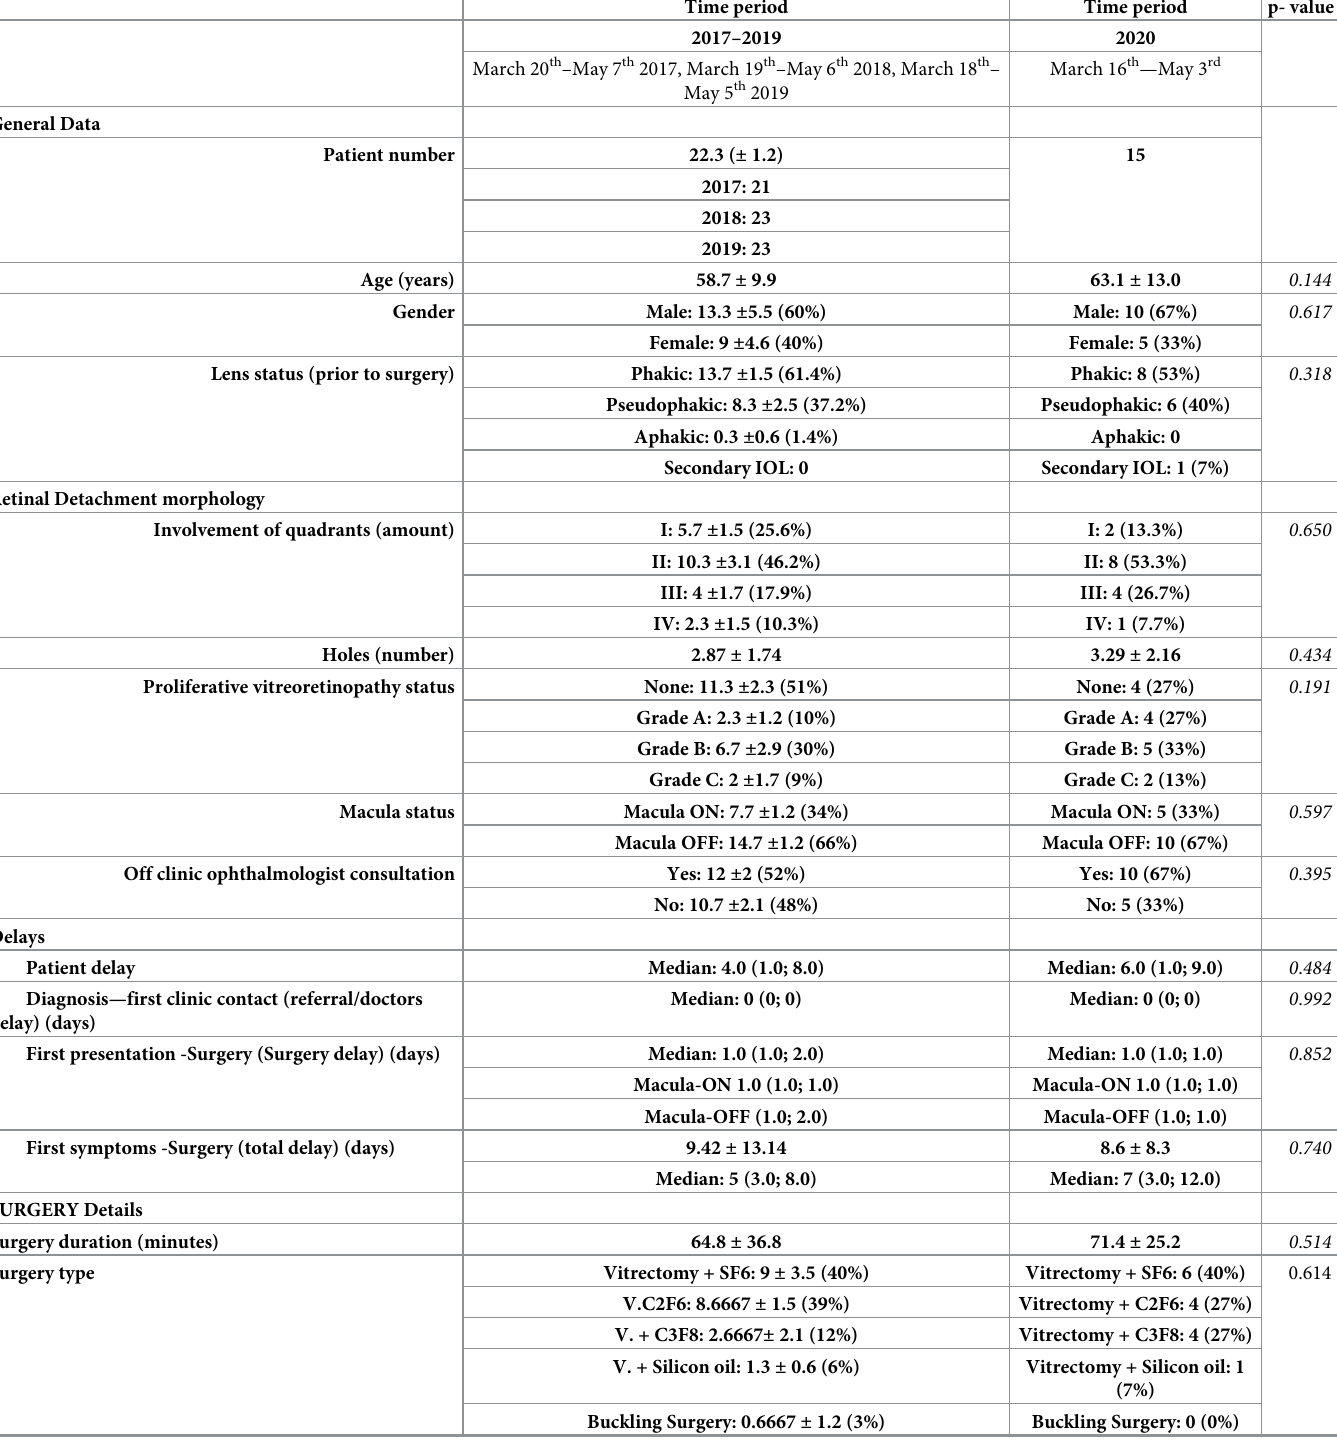
Table 1. Results, normal distributed data represented by the mean ± standard deviation, not normal distributed data represented by the median (lower quartile; upper